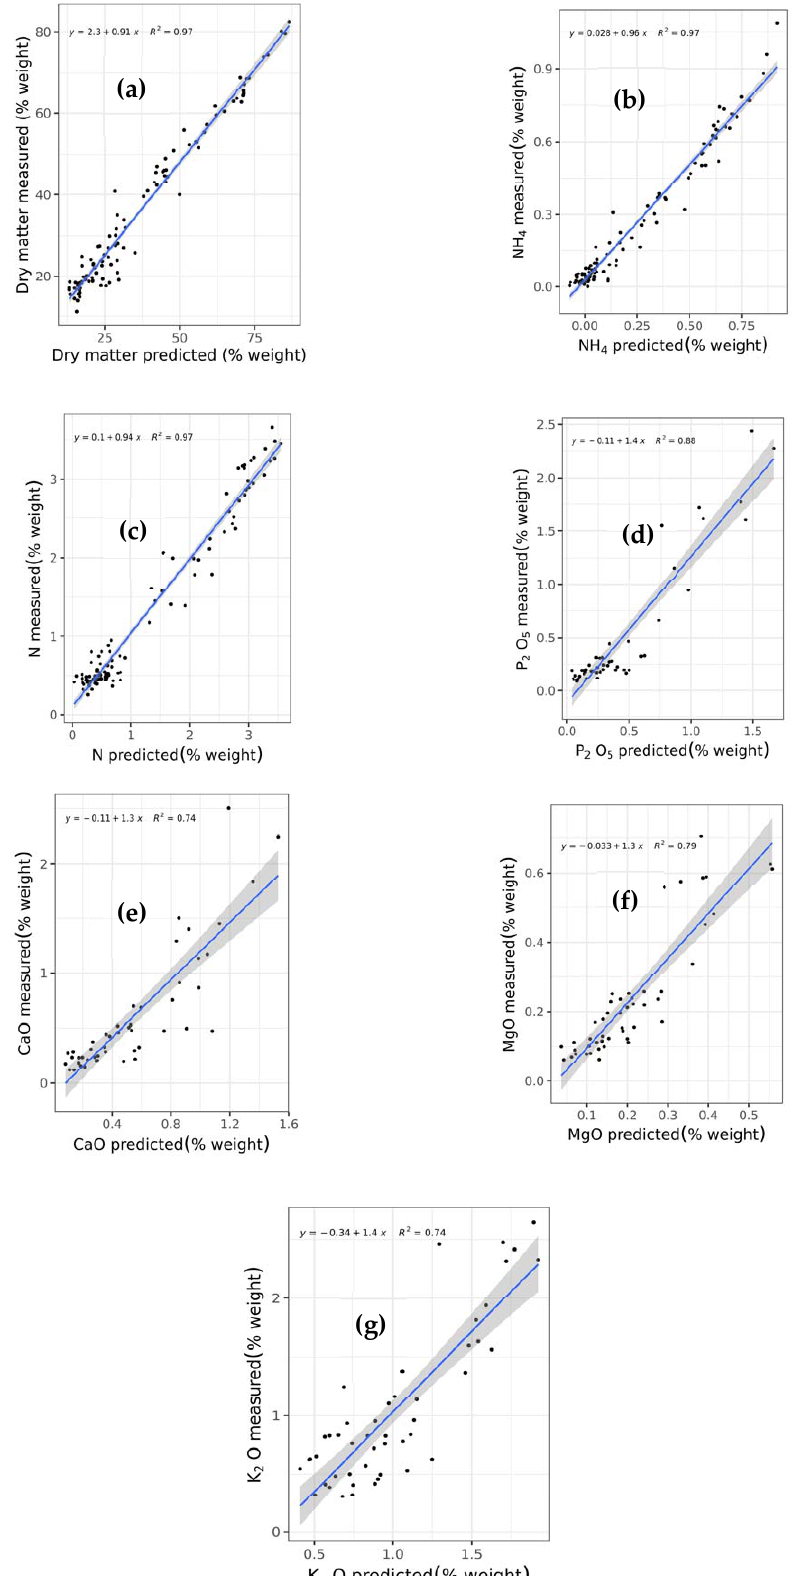
Figure 4. Predicted vs. measured concentrations of chemical constituents expressed as % wet weight of the fresh cattle and poultry manure for ( a ) dry matter, ( b ) total ammonium nitrogen (NH 4 ), ( c ) total